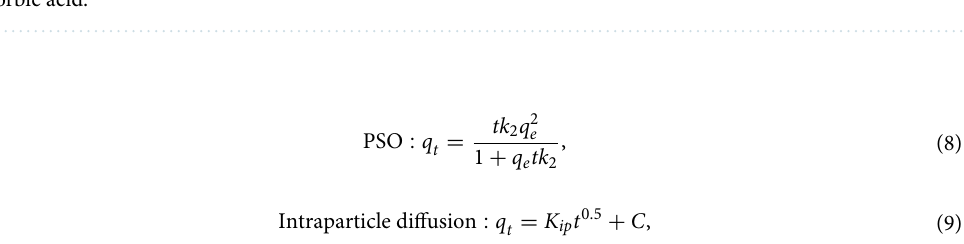
Table 4. Adsorption equilibrium and kinetics parameters for Cr(VI) adsorption onto tea waste treated with ascorbic acid.